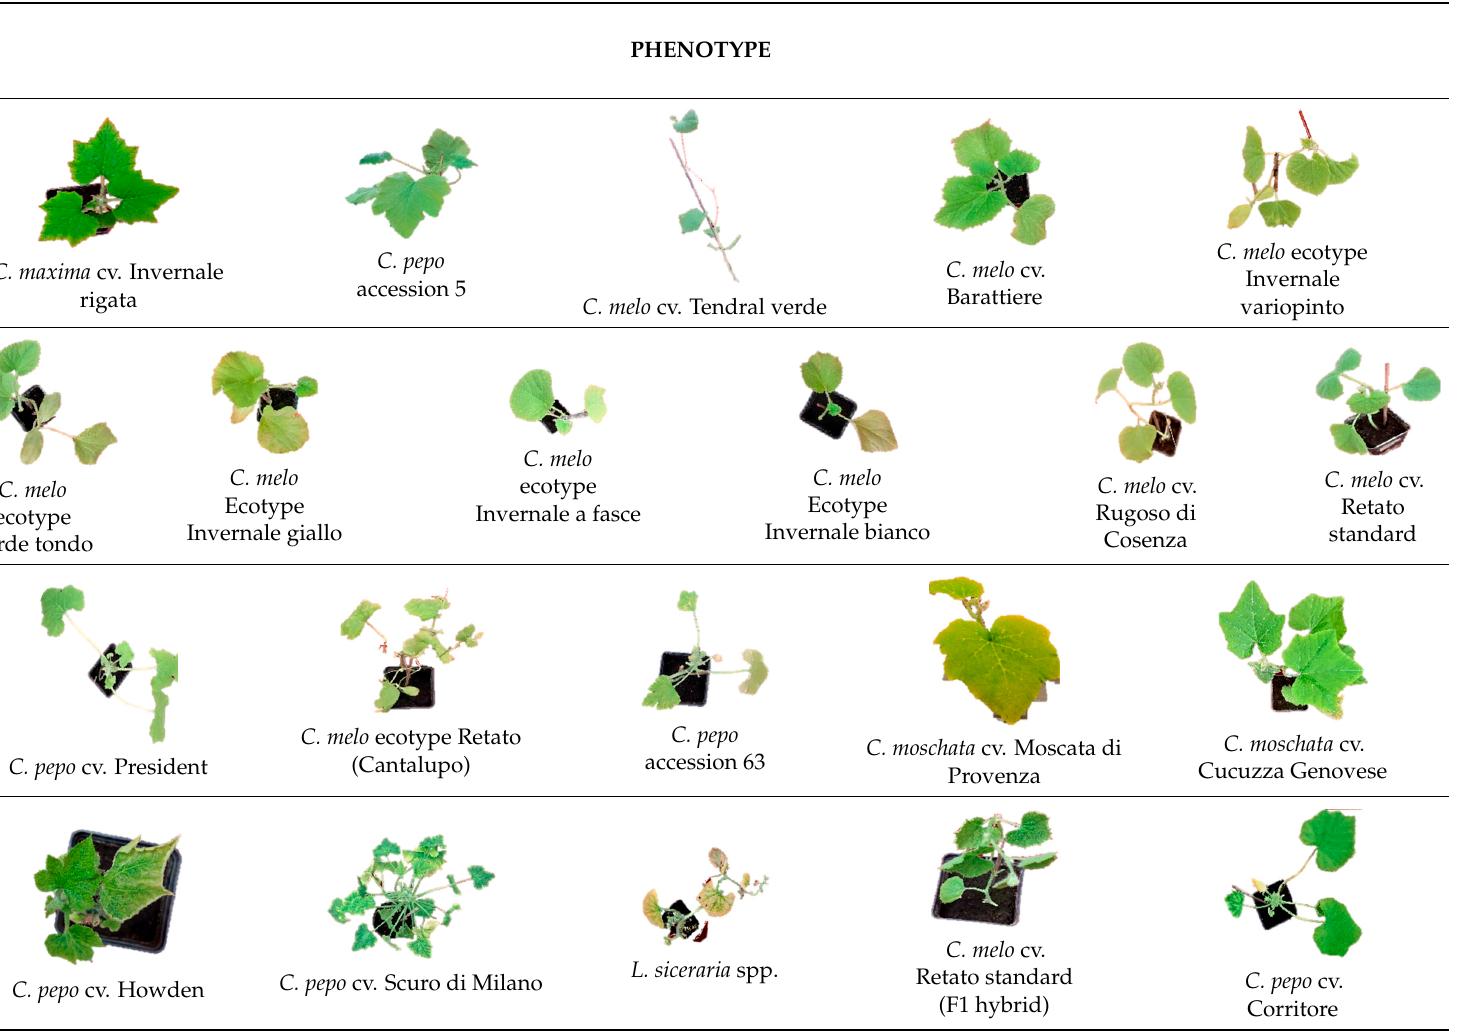
Table 1. Visual evaluation of symptoms induced by ToLCNDV-Le in Cucurbita , Cucumis, and Lagenaria spp. at 28 dpi classified as tolerant, moderately tolerant, moderately susceptible, and susceptible on the basis of disease symptoms developed.